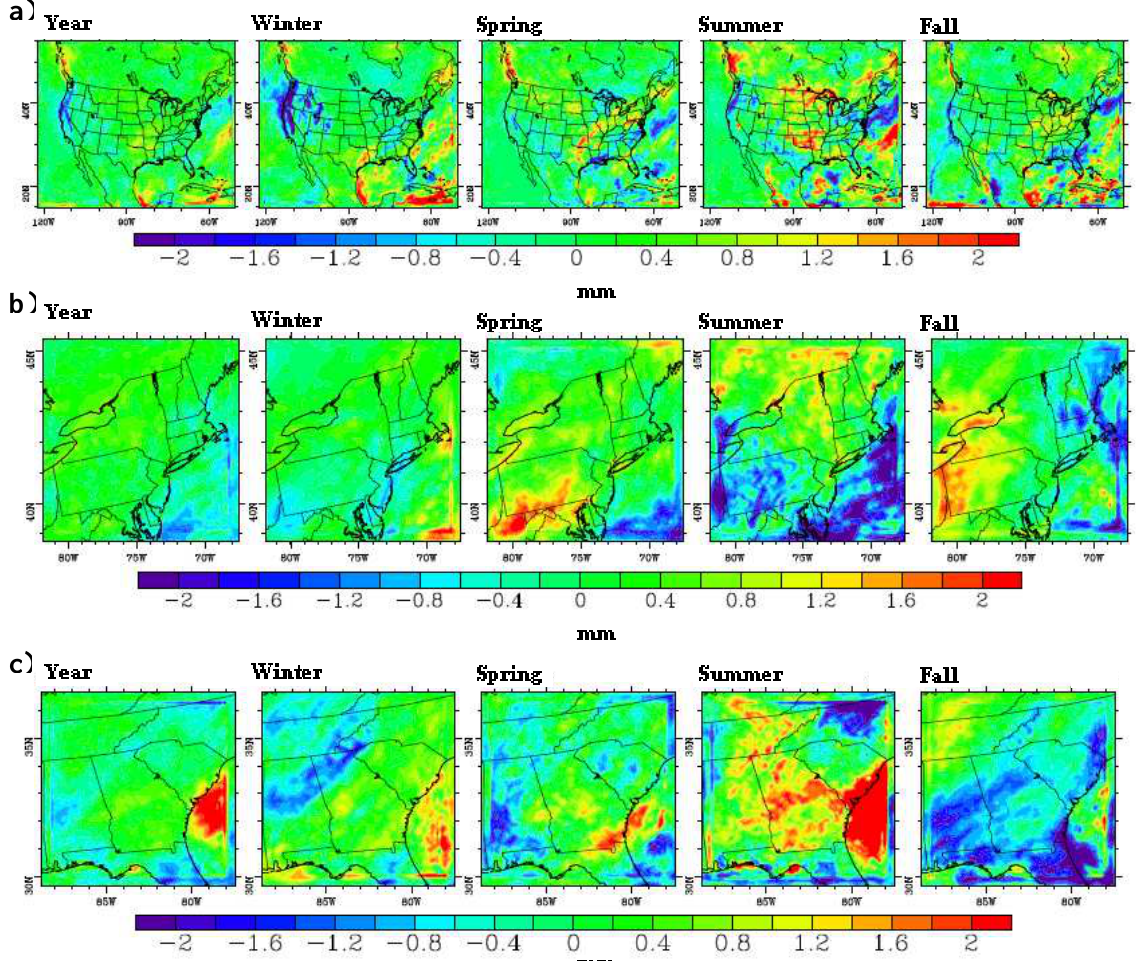
Fig. 3. (a) Predicted average yearly and seasonal precipitation (mmday − 1 ) change (future minus historic) for (a) the 36km × 36km resolution Figure 3: a) Predicted average yearly and seasonal precipitation (mm day -1 ) change (future 611 modeling domain, (b) the 12km × 12km resolution sub-domain over the Northeast and (c) the 12km × 12km resolution sub-domain over minus historic) for (a) the 36x36 km resolution modeling domain, (b) the 12x12 km 612 the